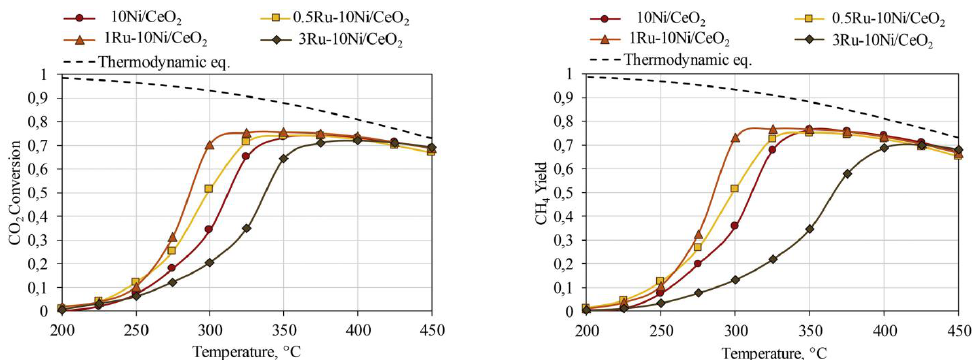
Figure 10. CO 2 conversion and CH 4 yield trends for the samples doped with 0.5%, 1% and 3% ruthenium (H 2 :Ar:CO 2 = 4:5:1; WHSV = 60 l/(h·g cat )). Reproduced with permission from [33]. Copyright: Elsevier, Amsterdam, The Netherlands, 2020.